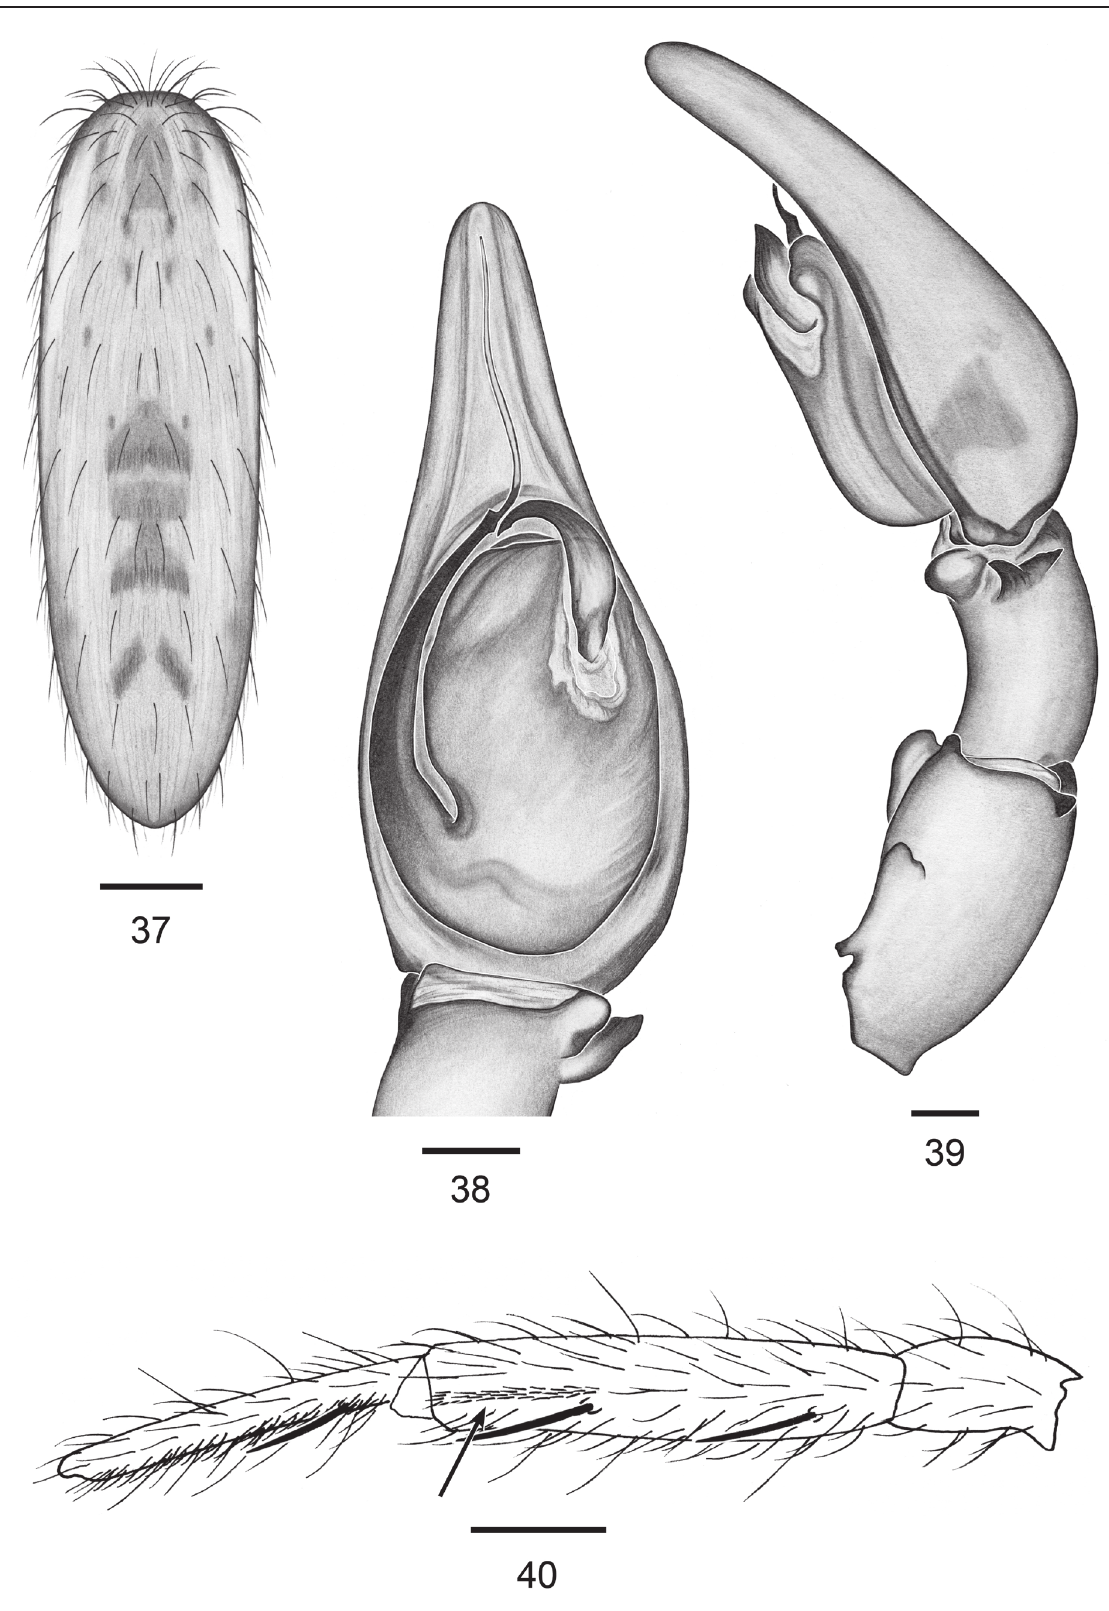
Figs 37–40. Shuyushka achachay gen. et sp. nov. 37 . ♂, abdomen, dorsal view. 38 . ♂, palp, ventral view. 39 . ♂, palp, retrolateral view. 40 . ♂, tibia I, prolateral view. Scale bars: 38–39 = 0.05 mm; 37, 40 = 1